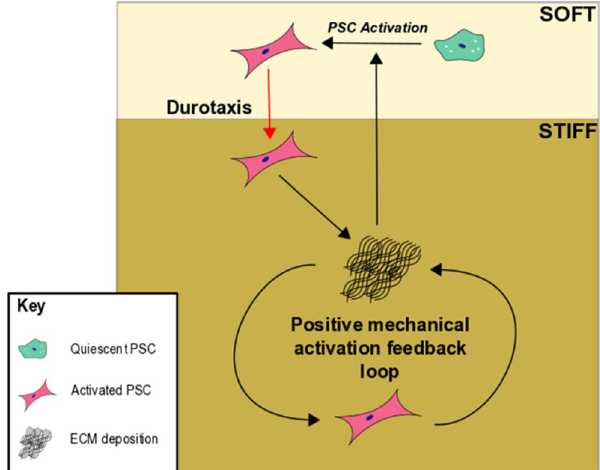
Figure 6. Illustration of PSC mechano-sensory driven regulation within a PDAC microenvironment. Under the effects of activating factors released from nearby cancer cells, local PSCs undergo phenotypic transition to a myofibroblast-like state, characterised by the secretion of vast amounts of ECM, providing a growth permissive environment for the neoplasm. Independently of PSC-cancer cell interactions, the generation of this highly stiff matrix mechanically activates local PSCs through mechanotransduction of the local microenvironment. This leads to increased matrix secretion and further PSC mechano-activation, resulting in the production of a positive mechanical activation feedback loop that produces a continually expanding region of fibrosis around the tumour. Such deposition leads to the generation of a stiffness gradient within the pancreas that is sensed by distant quiescent PSCs, causing them to undergo transition to an active state and begin durotactic migration towards the neoplasm, where upon they contribute to further matrix deposition. This accentuates the ever- growing area of fibrosis around the neoplasm through a vicious cycle of mechanically perturbed PSC